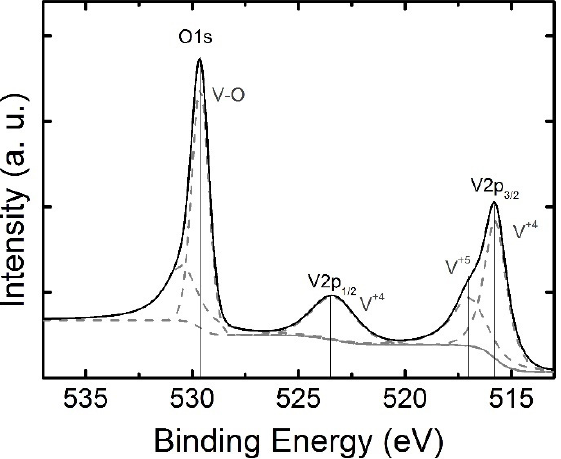
Figure 3. The XPS fine spectrum (O1s and V2p levels) of the VO 2 NWs. Two peaks at 515.8 and 523.5 eV corresponded to V2p 3/2 and V2p 1/2 and showed the V +4 oxidation state. The presence of the V +5 component in the VO 2 NWs denotes an over-oxidation, due to the existence of V 2 O 5 at the surface of the VO 2 NWs from air exposure.